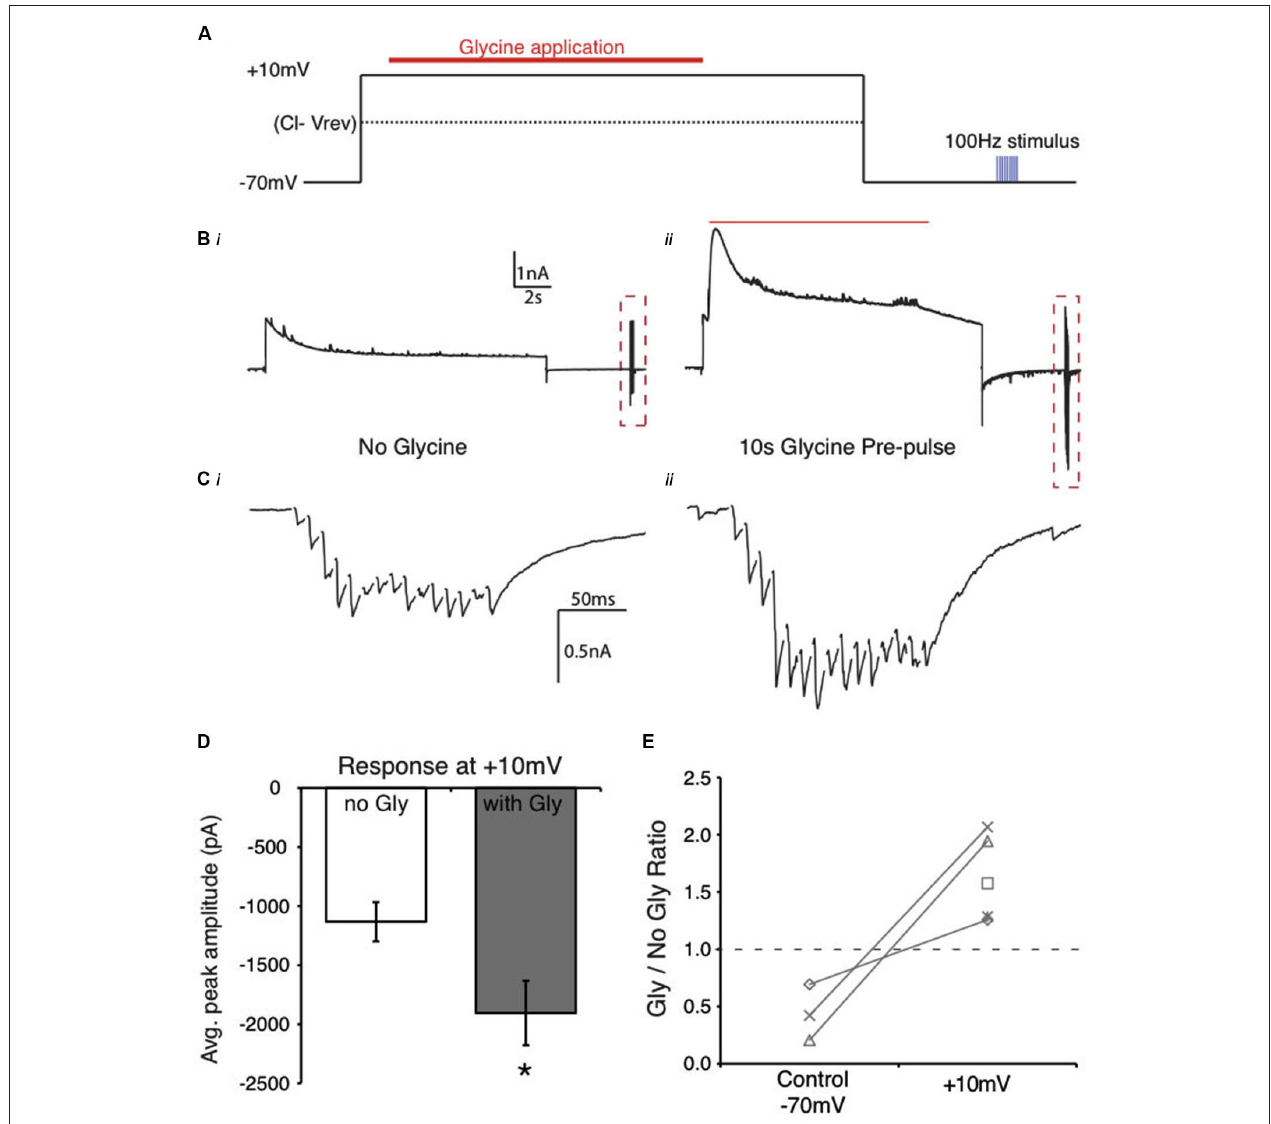
amplitudes of the evoked IPSCs in the control (no gly) and in the presence of glycine pre-application (* indicates significant difference, p < 0.01). (E) Ratio of peak amplitude between Gly/no Gly conditions in control and when glycine pre-pulse occurred at +10 mV. The ratios were >1 in each cell when glycine application occurred during the +10 mV voltage step. Dashed line represents a ratio of 1, indicating no change in evoked